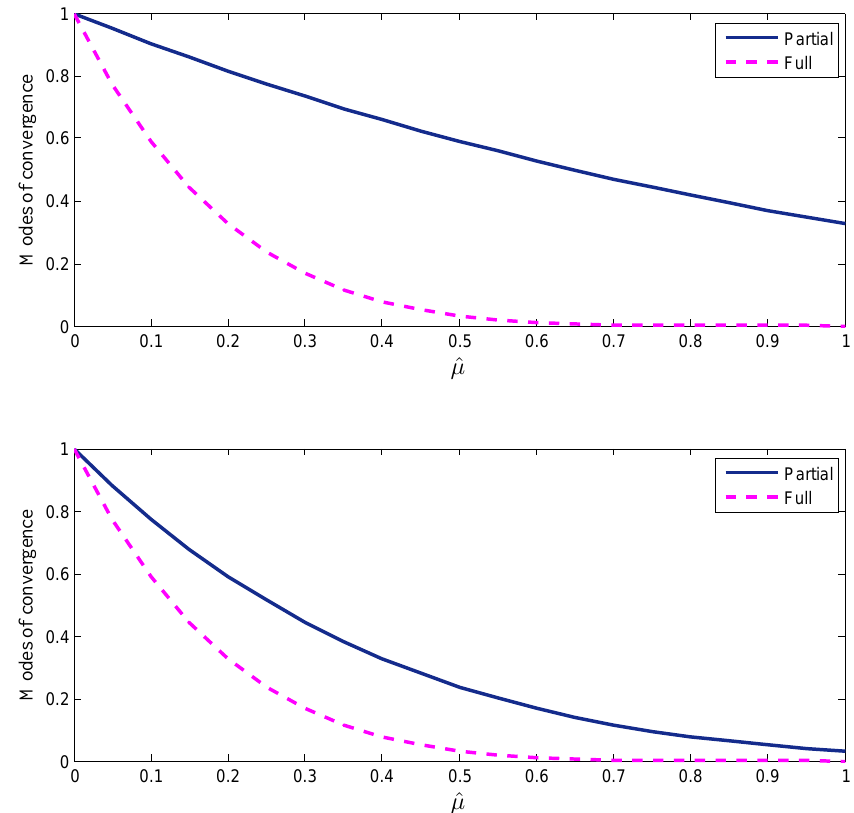
Figure 6. Modes of mean-convergence, for ILMS and CD-ILMS algorithms using K = 10, π = 0.8 ( top ) and π = 0.5 ( bottom